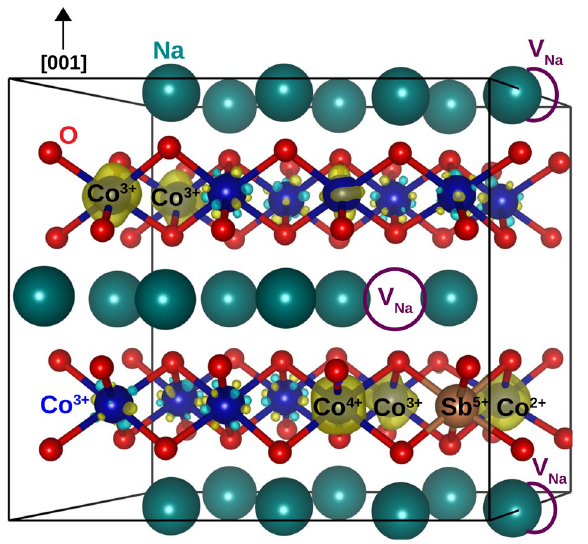
Fig. 5 The spin density of the 2 a × 4 a × 1 c supercell used for simu- lating Sb-doped Na 0.875 CoO 2 compound when Sb 5+ is not in the immediate vicinity of the V Na s. The distance between V Na and Sb 5+ is marked with dotted brown